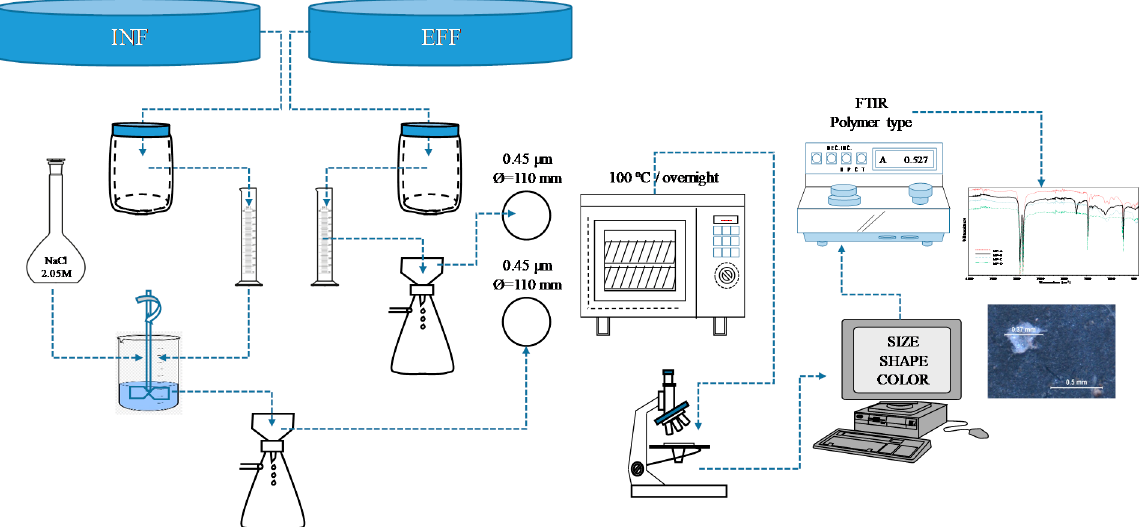
Figure 1. Flow diagram for the analysis of microplastics in “La Aljorra”